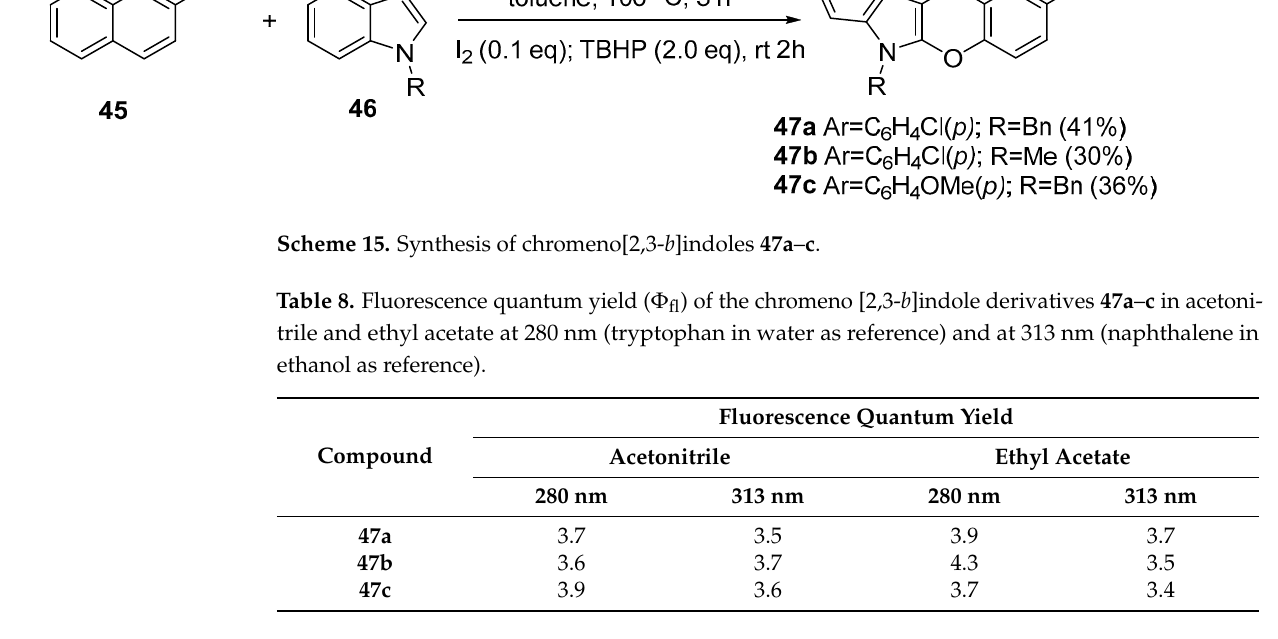
Table 8. Fluorescence quantum yield ( Φ fl ) of the chromeno [2,3- b ]indole derivatives 47a – c in ace- tonitrile and ethyl acetate at 280 nm (tryptophan in water as reference) and at 313 nm (naphtha- lene in ethanol as reference).